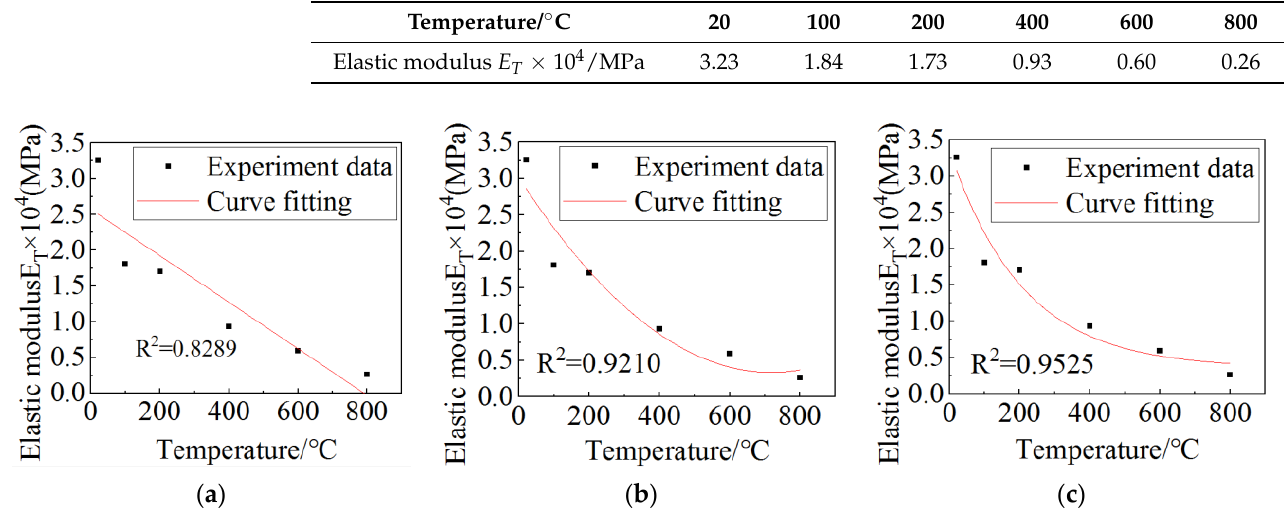
Figure 5. Fitting curve of temperature and elastic modulus: ( a ) linear fitting; ( b ) polynomial fitting; ( c ) exponential fitting.